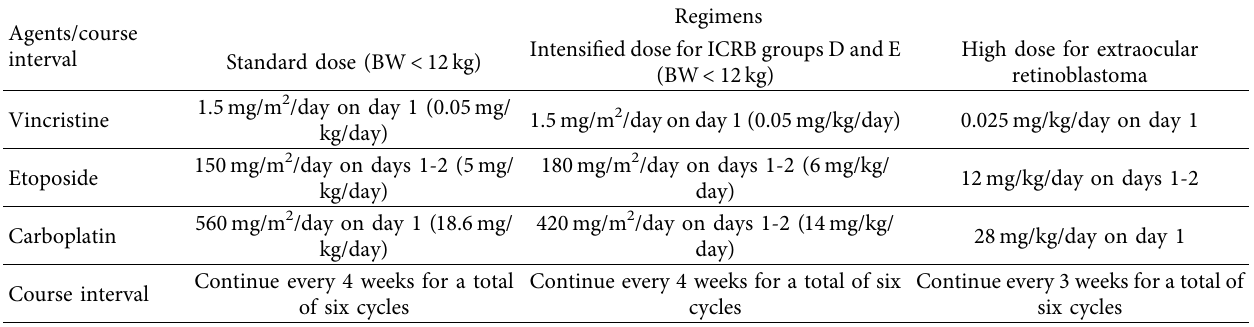
Table 1: Retinoblastoma chemotherapy regimens [37,